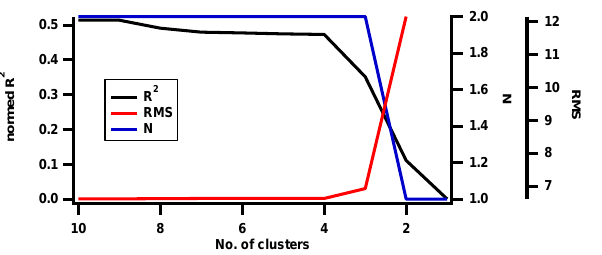
Fig. 6. Ambient WIBS3 data set clustering statistics. Four cluster solution chosen due concomittent drop in R 2 and rise in RMS.